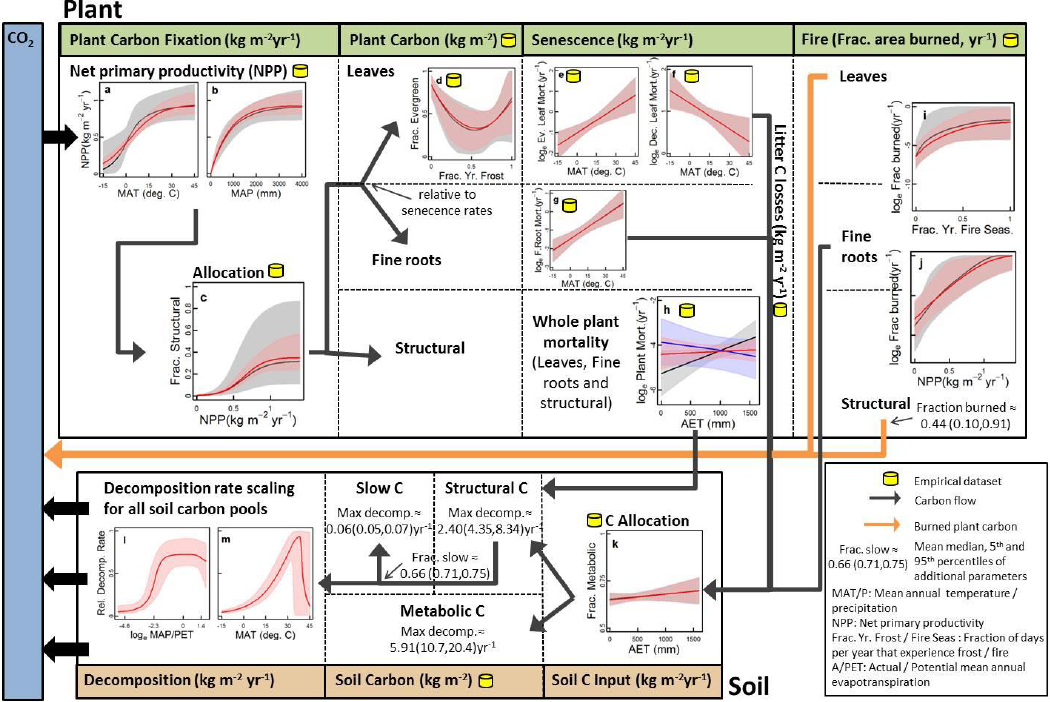
Fig. 1. Summary of the inferred climate dependence of the terrestrial carbon cycle within our terrestrial carbon model. The inferred climate dependence of each component is shown in red (inferred using the full model and all data sets), grey (inferred using minimal subsets of the model) and, to illustrate the major structural uncertainty in plant mortality ( h ), in blue (inferred using the full model but omitting the plant mortality data). Lines and shading are average median, 5th and 95th percentiles from 10 training data subsets.